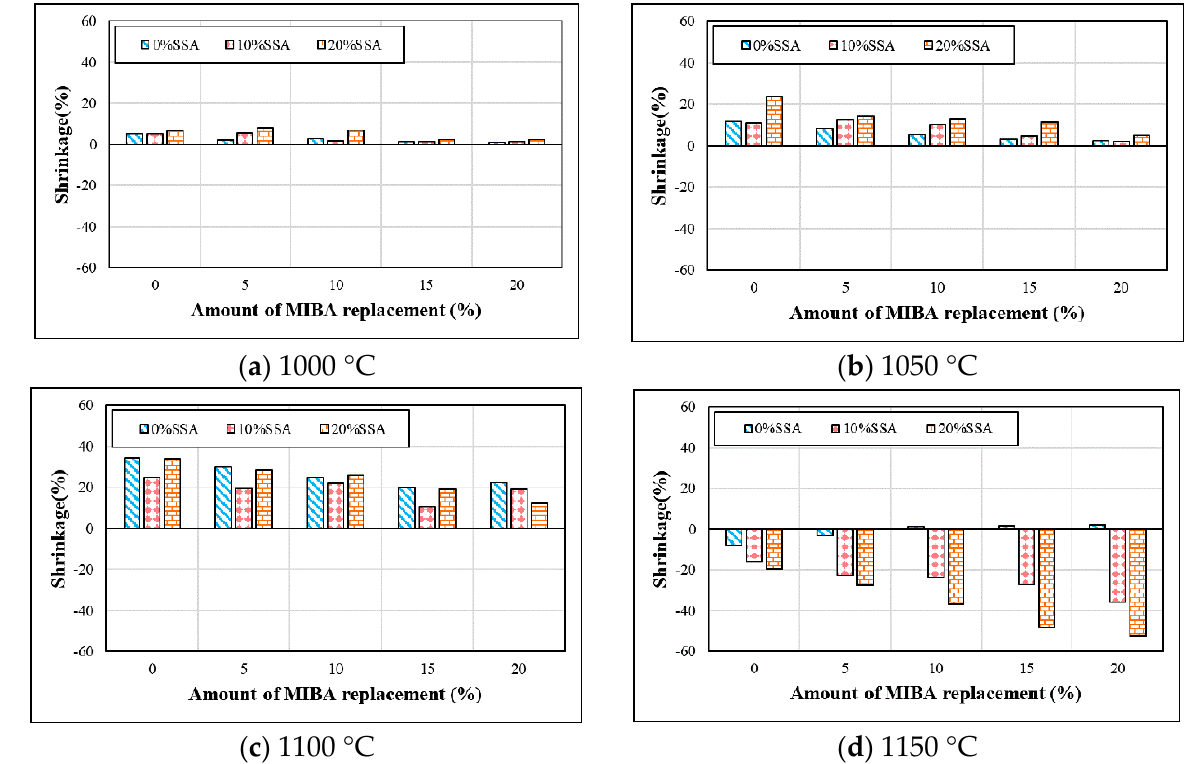
Figure 4. Shrinkage at different sintering temperature. ( a ) 1000 ◦ C; ( b ) 1050 ◦ C; ( c ) 1100 ◦ C; ( d ) 1150 ◦